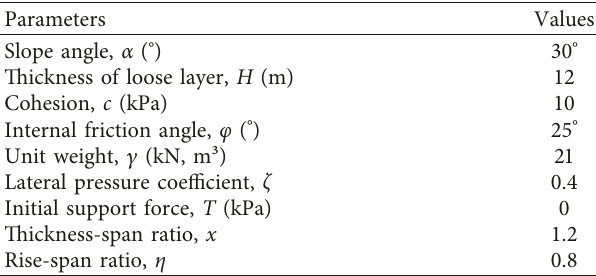
Table 2: Relevant calculation